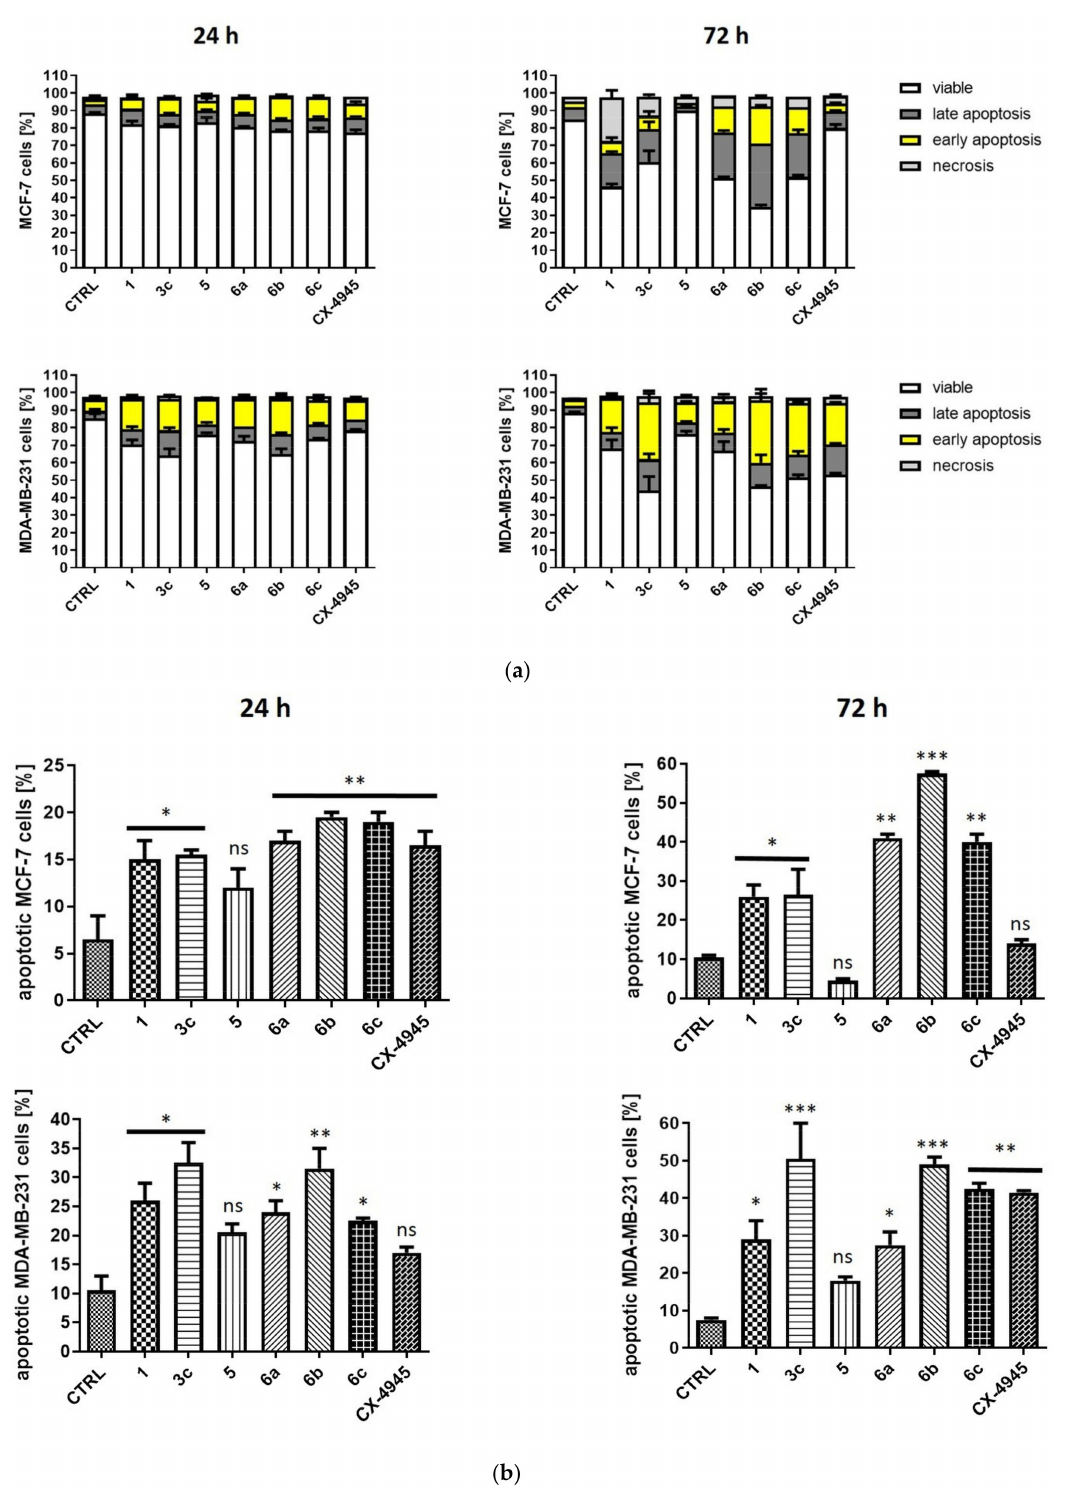
Figure 9. Effect of compounds 1 , 3c , 5 and 6a – c on progression of apoptosis/necrosis in MCF-7 and MDA-MB-231 cells. ( a ) Percentage of viable, early and late apoptotic, and necrotic cells, after 24 h and 72 h of treatment with the tested compounds used in the concentrations corresponding to their EC 50 values for 72-h treatment. ( b ) Percentage of apoptotic cells (sum of the percentage of cells in early and late apoptosis) after 24-h and 72-h treatment with the tested compounds. Cells were stained with annexin V-FITC and PI (propidium iodide). CX-4945 was used as a positive control. The data were determined by CyFlow Cube 8, (Sysmex, Norderstedt, Germany) flow cytometer. Graphs represent mean values ± s.e.m. * p < 0.05, ** p < 0.01, *** p < 0.001 relative to control; ns—not